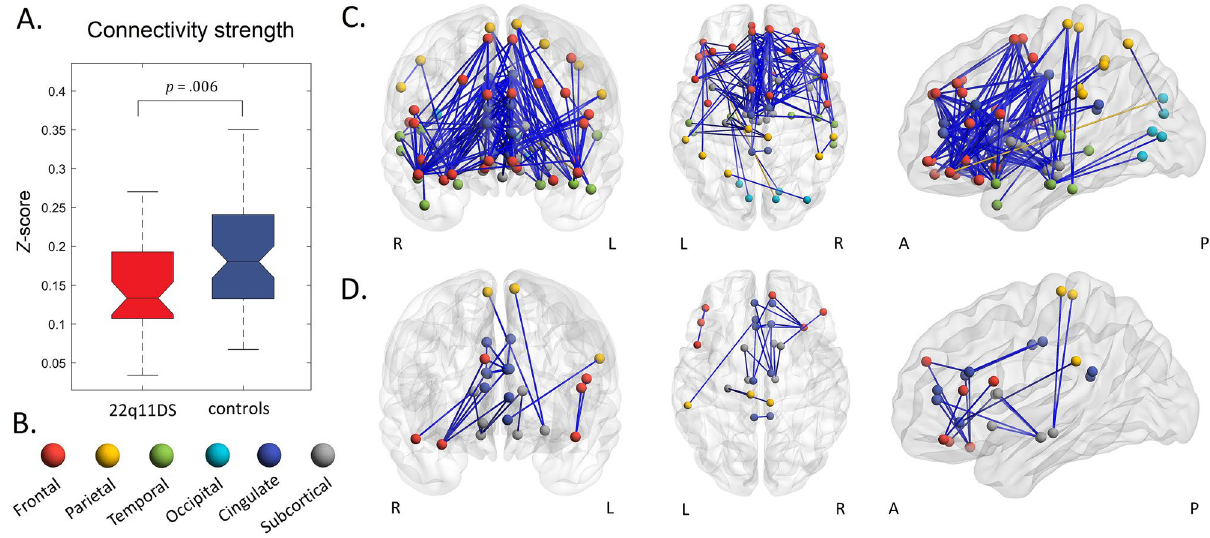
Figure 1. Functional connectivity is reduced in 22q11 deletion syndrome patients. ( A ) Average connectivity strength is lower in patients ( t (101) = − 2.75, p = 0.007). ( B ) Anatomical locations of nodes in the network. ( C ) Functional connectivity (FC) is significantly different in 193 connections, 192 connections (blue) depict lower Z -scores in patients, one connection (yellow) is increased in connectivity. Covariates included in the model: age, gender, mean FD and history of psychosis. ( D ) Twenty-three connections are decreased in FC after correcting for an overall lower connectivity in 22q11 deletion syndrome patients. Covariates included the model: age, gender, history of psychosis, mean FD, and mean